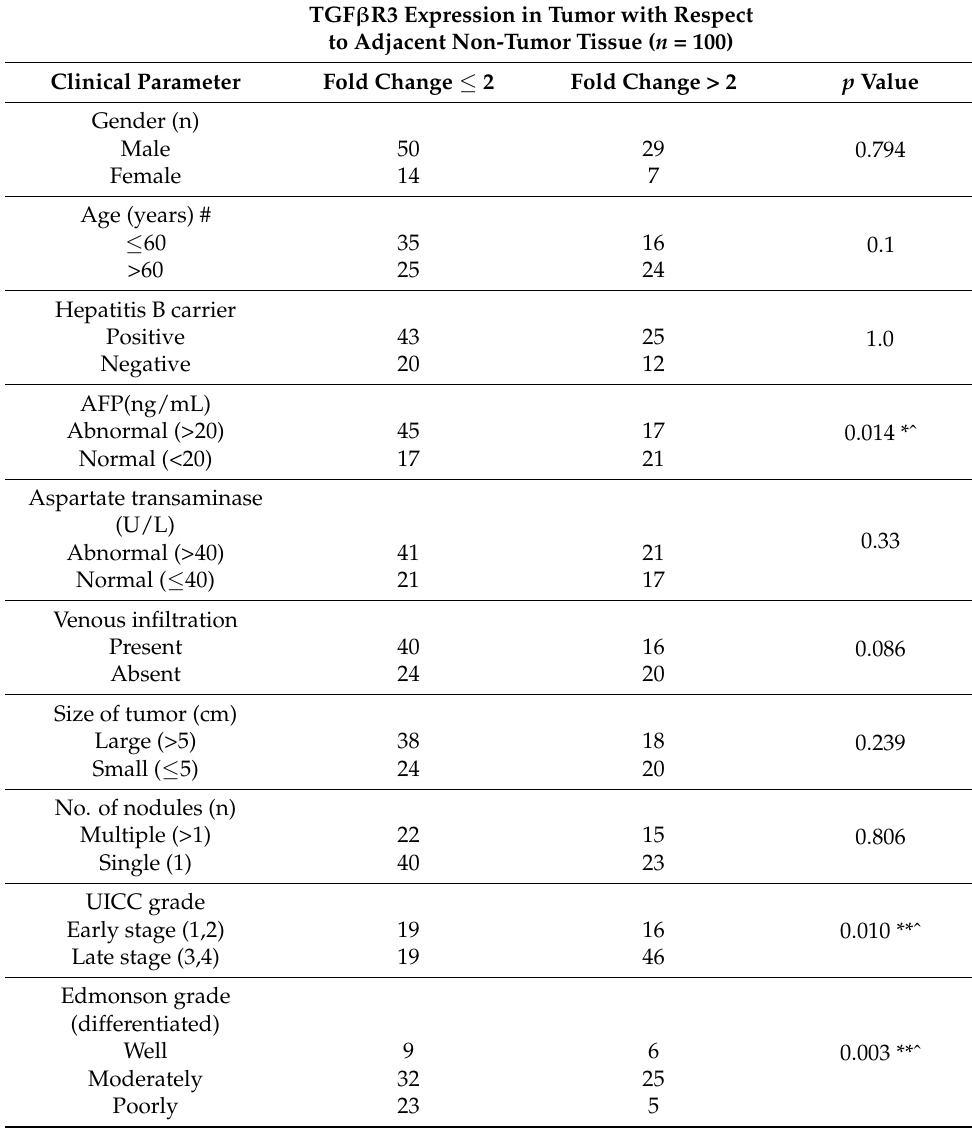
Table 1. Correlation between TGF β R3 and clinicopathologic parameters. TGF β R3 Expression in Tumor with